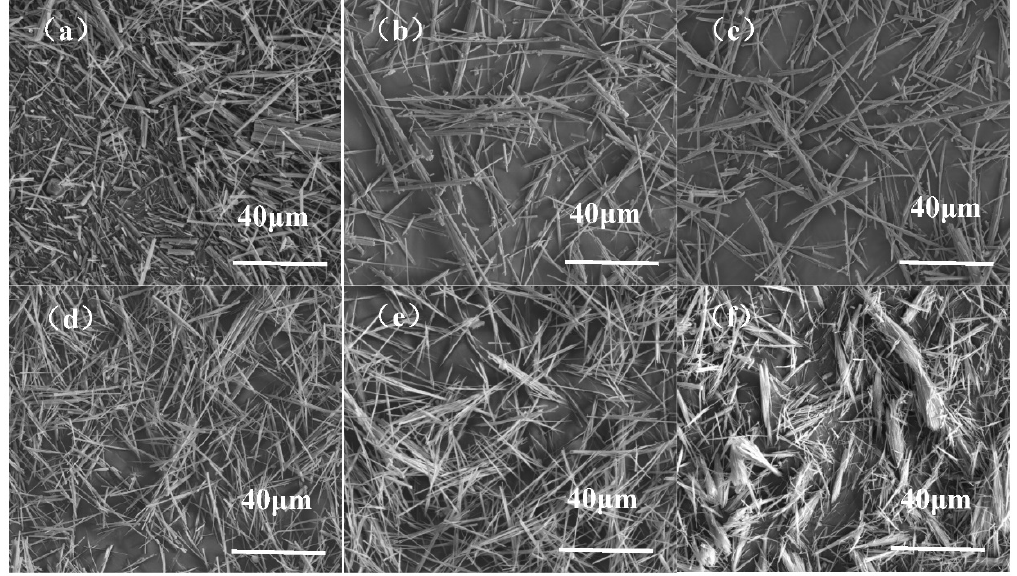
Figure 13. SEM images of samples prepared in different glycerol concentrations: ( a ) 0%, ( b ) 20%, ( c )